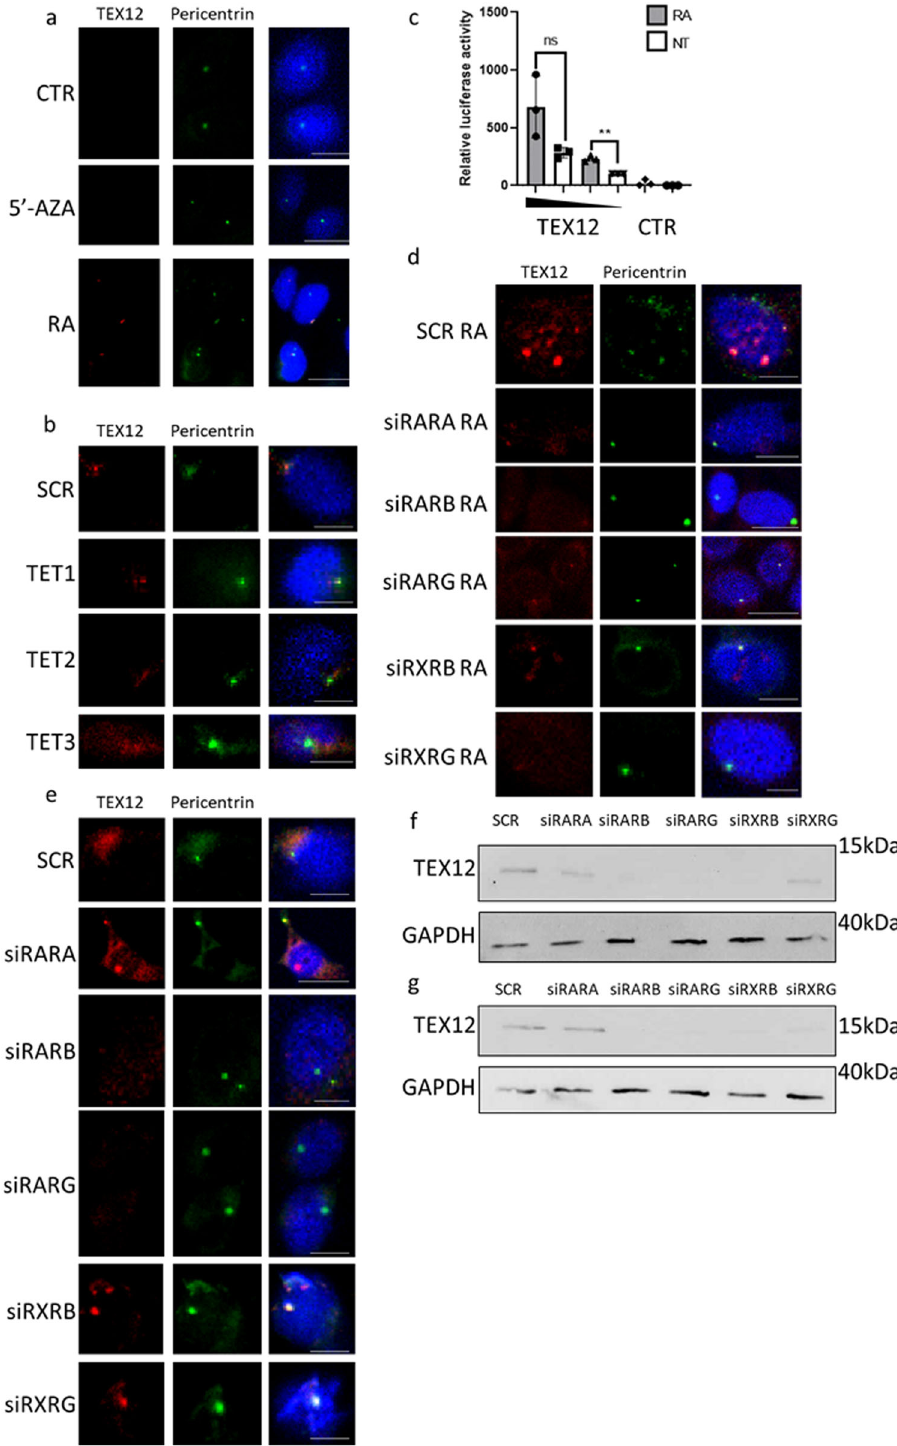
Fig. 7 TEX12 re-expression is not regulated by demethylation but by retinoic acid signalling. a U2OS cells were left untreated or treated with 3 µ M 5-azacytidine (5-AZA) or 1 µ M retinoic acid. Bar = 20 µ m. b PC3 cells were treated with siRNA as indicated. Bar = 20 µ m. c HEK293T cells untransfected (CTR) or transfected with the increasing quantity of pGL4-TEX12 (221bp) (as indicated by the triangle) or pGL4-SCR plasmid. Luciferase (Luc) activities were normalised to 1 µ g plasmid NT. All data is shown as mean of normalised luciferase activities ± SD of three independent experiments and signi fi cant differences between each group were determined by student ’ s paired t -test (** p < 0.01, ns = not signi fi cant). d U2OS cells treated with or 1 µ M retinoic acid and siRNA as indicated with corresponding quanti fi cation. NT non treated. TEX12 intensity measured in 10 cells per condition from three independent experiments. Bar = 20 µ m. e PC3 cells treated with siRNA as indicated. Bar = 20 µ m. f U2OS cells treated with or 1 µ M retinoic acid and siRNA as indicated with corresponding quanti fi cation. g PC3 cells treated with siRNA as